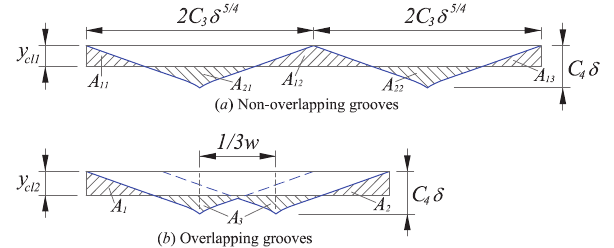
Figure 6. Illustration of non-overlapping and overlapping for two adjacent